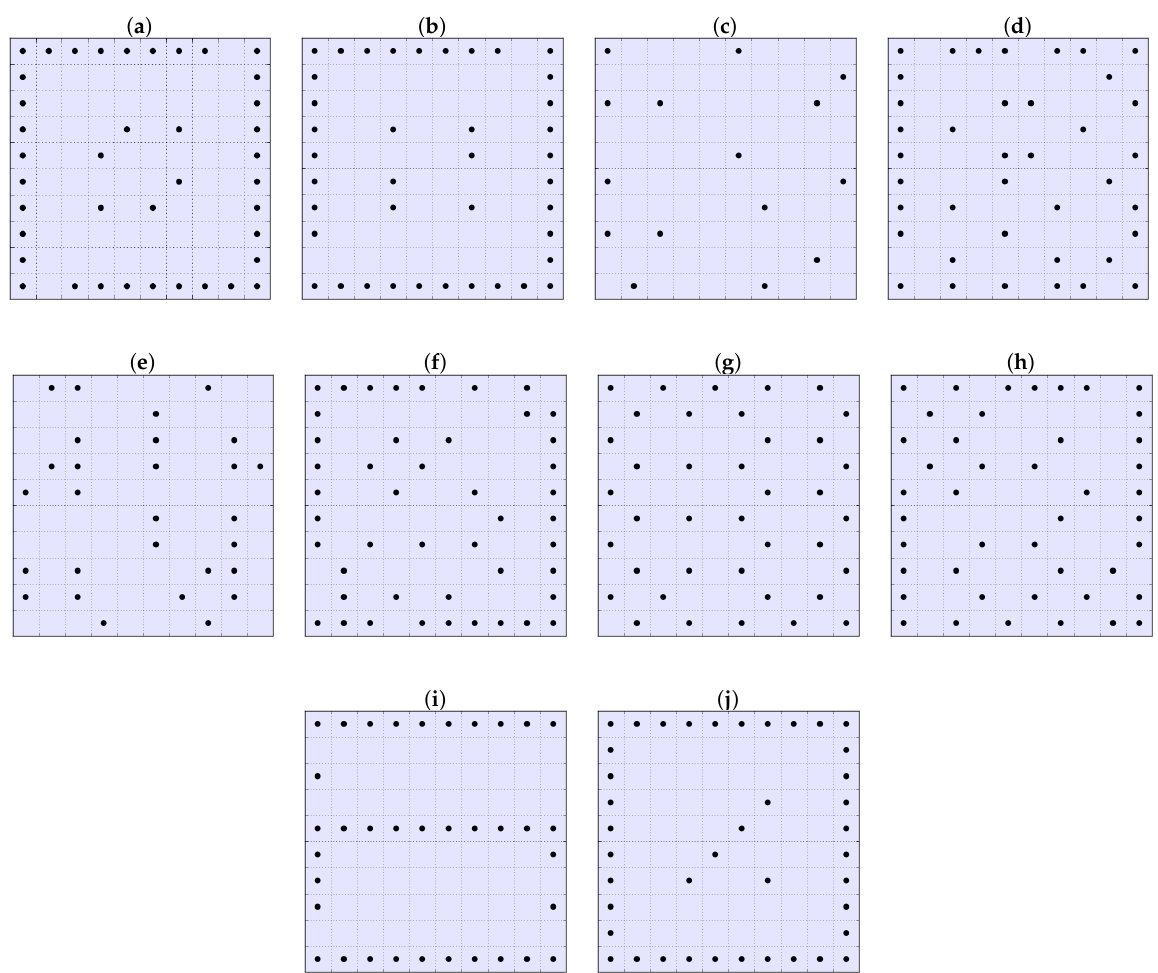
Figure 18. Reported optimal wind farm layouts for case 4. ( a ) Present (SO). ( b ) Present (MO). ( c ) Mosetti et al. [3]. ( d ) Grady et al. [7]. ( e ) Emami et al. [9]. ( f ) Pookpunt et al. [11]. ( g ) Turner et al. [12]. ( h ) Yang et al. [10]. ( i ) Ulku et al. [13]. ( j ) Yang et al.